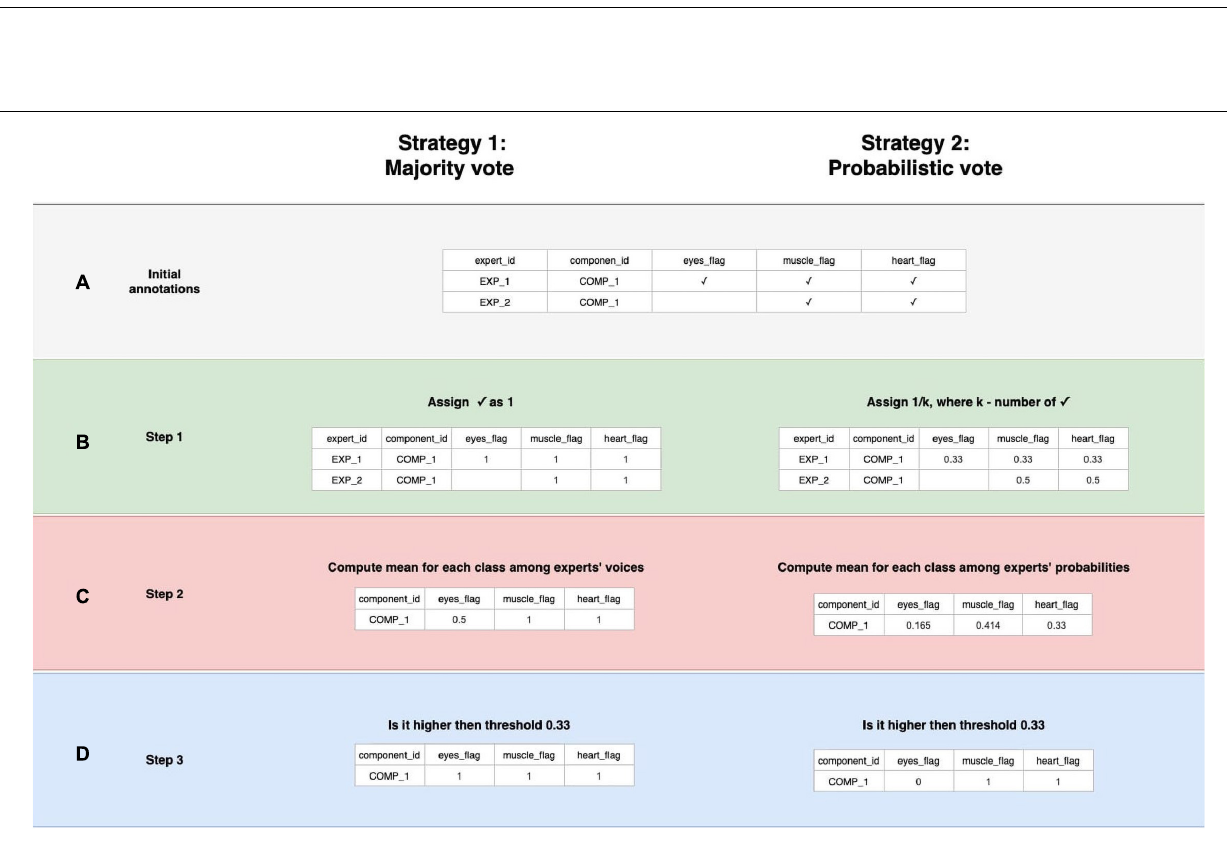
FIGURE 4 | Data labeling strategies. There are several annotations for one component from various experts, but we strive to designate its belonging to a particular class strategies of data belling aggregation, those are “Majority vote” and “Probabilistic vote.” (A) Is a table of annotations of a specific component. (B) Transform into a matrix of probabilities that each component belongs to a particular class. (C) Group the experts’ opinions using the mean of the probabilities to obtain a weighted probability . (D) Determine whether the weighted probability is higher than the threshold or